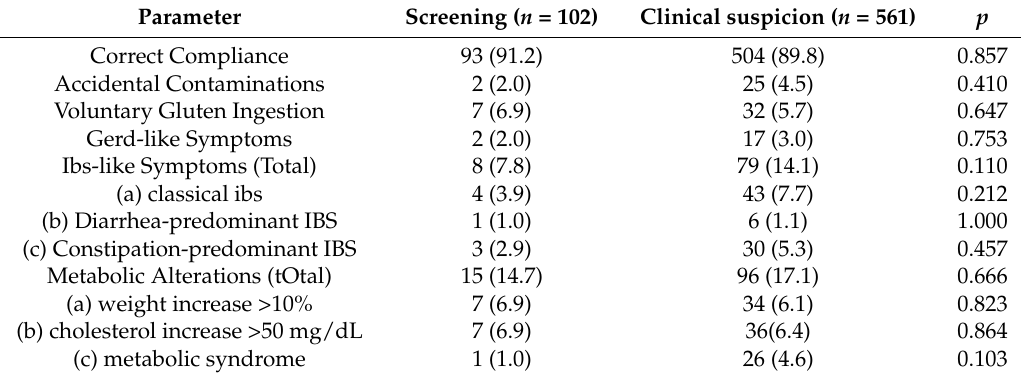
Table 3. Comparison of the compliance to the gluten-free diet, persisting symptoms, and metabolic alterations at the follow-up evaluations between screening- and clinically detected